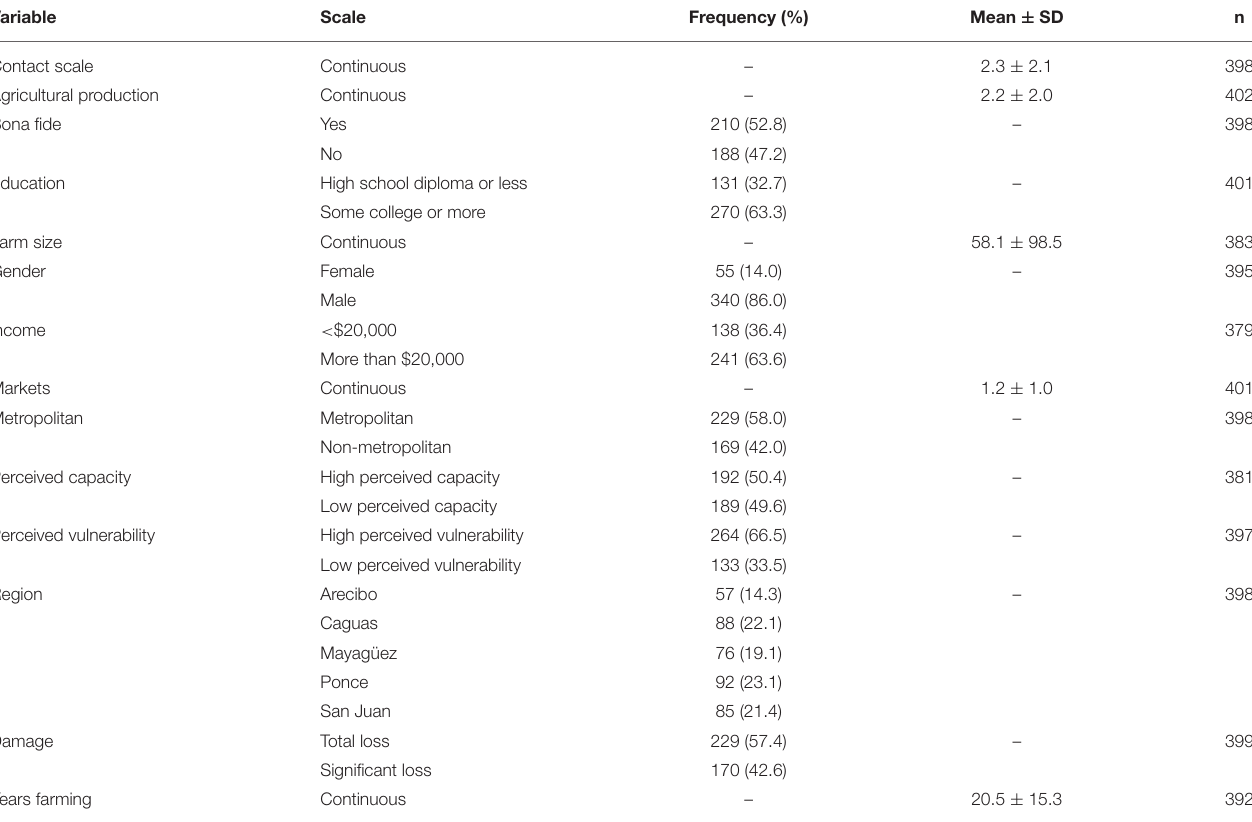
TABLE 4 | Descriptive statistics of independent